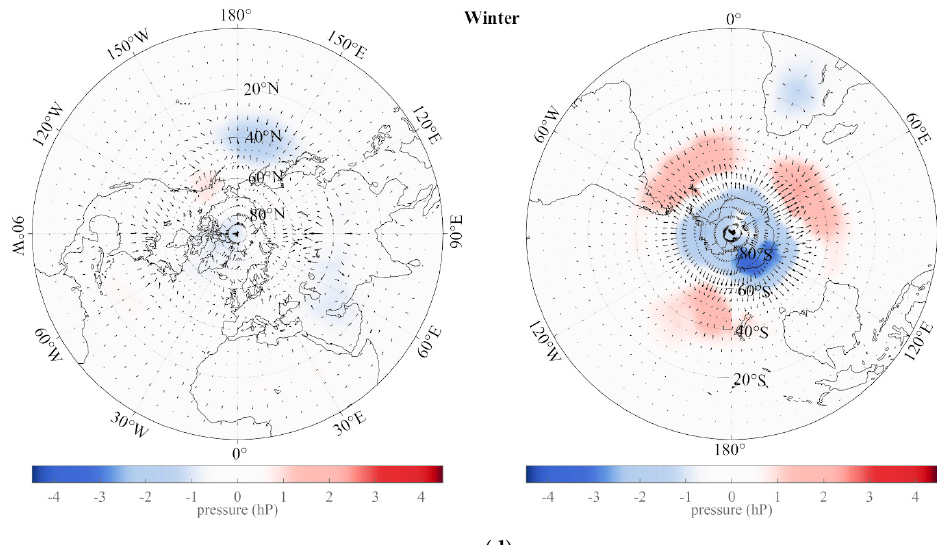
Figure 7. Same as Figure 5 but for the semi-annual oscillation (SSA component 3): ( a ) during springs; ( b ) during summers; ( c ) during autumns; ( d ) during winters.